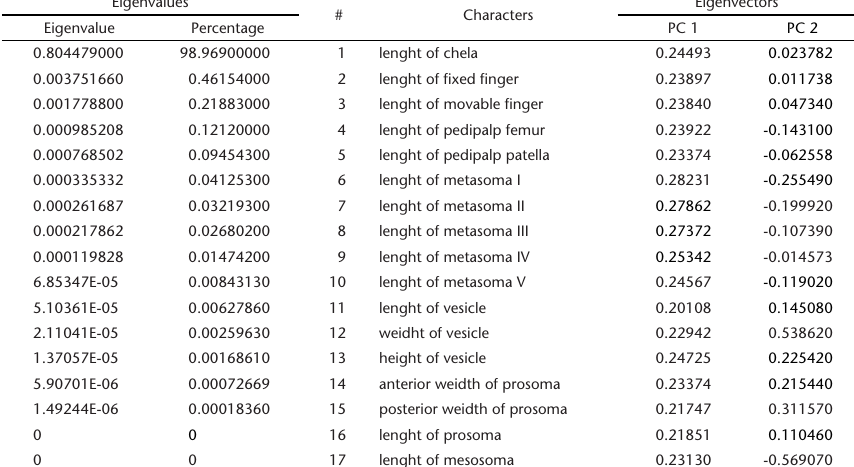
Table 2. Results from the PCA for Troglorhopalurus translucidus collected in caves from Igatu, Bahia state. Eigenvalues on the left and eigenvectors on the right-hand columns, respectively. Bold type indicates characters that contributed for the most variation in PCA analyses.